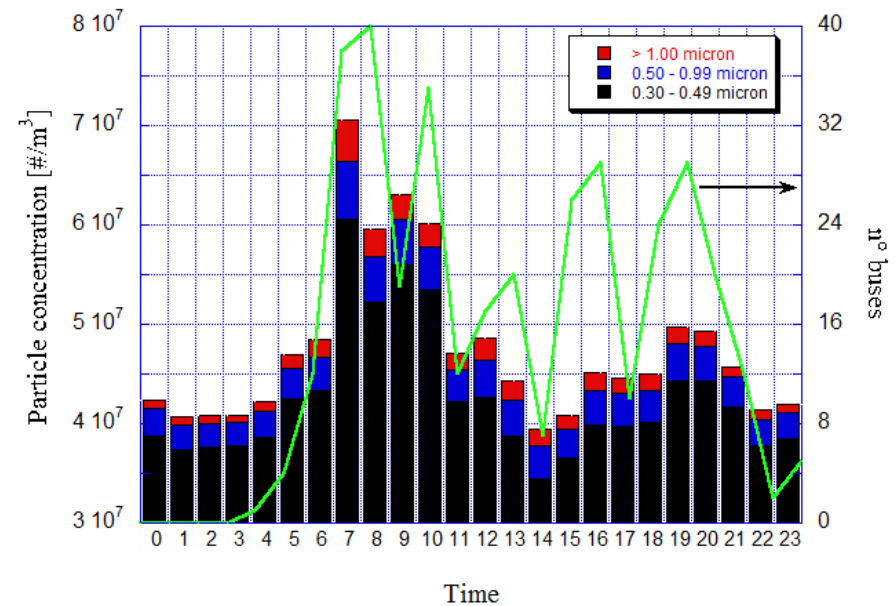
Figure 9. Hourly trend of the PM mean number concentration (left column) monitored in the bus terminal (level − 1 ) of Collemaggio parking site, L’Aquila, in the period June 2016–August 2016. Three granulometric sizes are shown: 0.30–0.49 µm, 0.50–0.99 µm and >1.00 µm. Analysis of hourly averages. Data collected by OPC TSI . The green line (right column) indicates the total number of incoming and outgoing buses from the terminal.